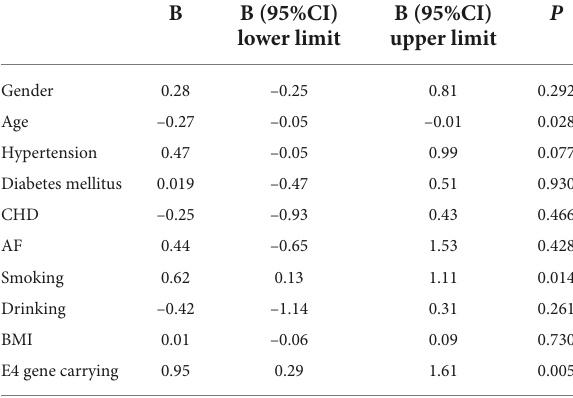
TABLE 5 Analysis of factors influencing plaque length following atorvastatin therapy.